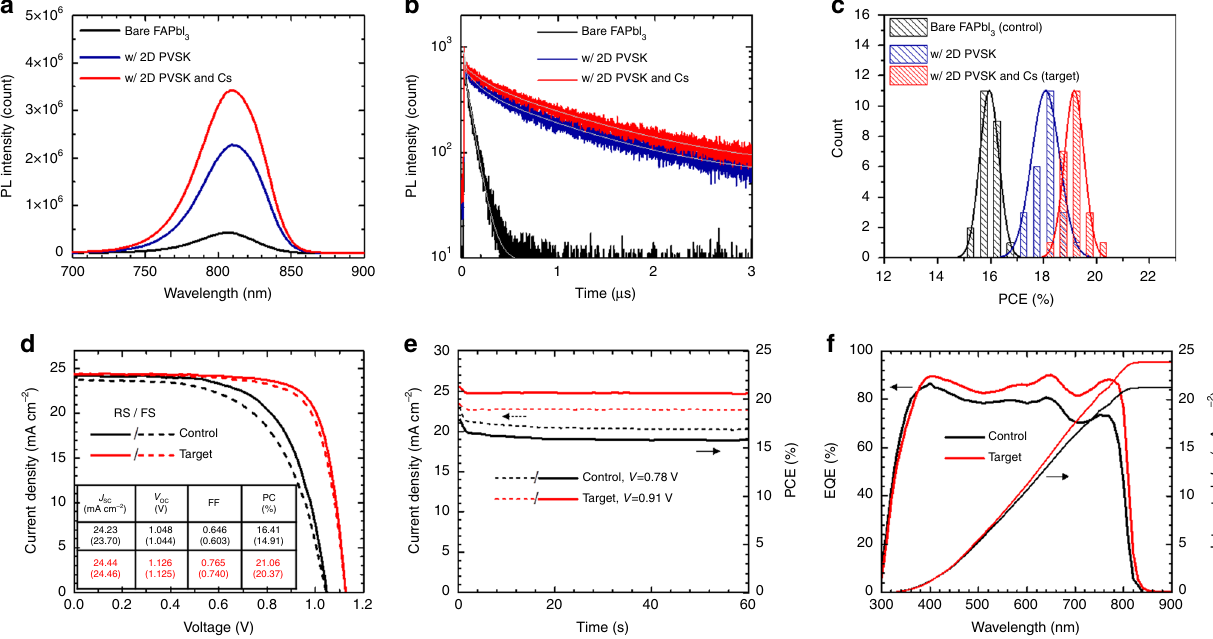
Fig. 2 Photoluminescence properties and photovoltaic performance. a Steady-state and b time resolved PL spectra of the perovskite fi lms incorporating bare FAPbI 3 , FAPbI 3 with 2D perovskite and FA 0.98 Cs 0.02 PbI 3 with 2D perovskite. Gray solid lines in b are fi tted lines for each curve. c Power conversion ef fi ciency (PCE) distribution of the devices incorporating the perovskites. All the devices were fabricated in same batch. d Current density – voltage ( J – V ) curves, e steady-state PCE measurement and f external quantum ef fi ciency (EQE) spectra of perovskite solar cells incorporating bare FAPbI 3 (control) and FA 0.98 Cs 0.02 PbI 3 with 2D perovskite (target). Photovoltaic parameters of the highest performing devices are summarized in the table in d , in which the values with and without parenthesis are from reverse (from V OC to J SC ) and forward scan (from J SC to V OC ), respectively NATURE COMMUNICATIONS| (2018) 9:3021 |DOI: